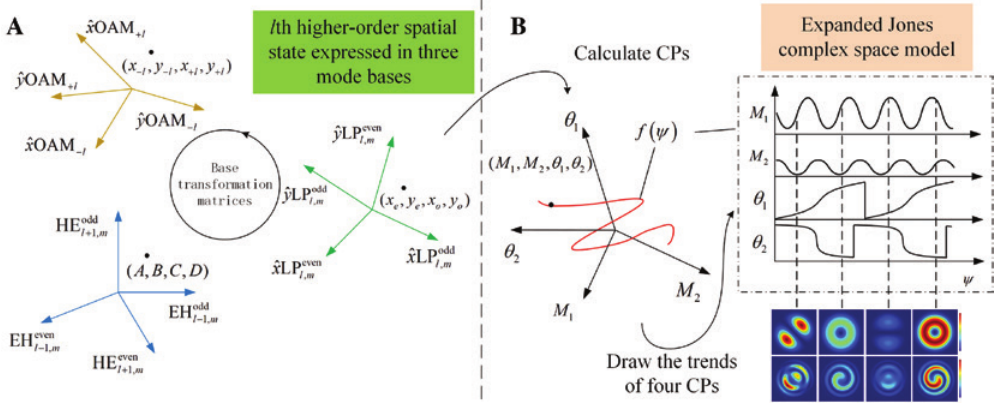
Figure 2: Sketch of the expanded Jones model. (A) The transformation among three kinds of spatial states; (B) the mathematical nature and procedure of the expanded Jones